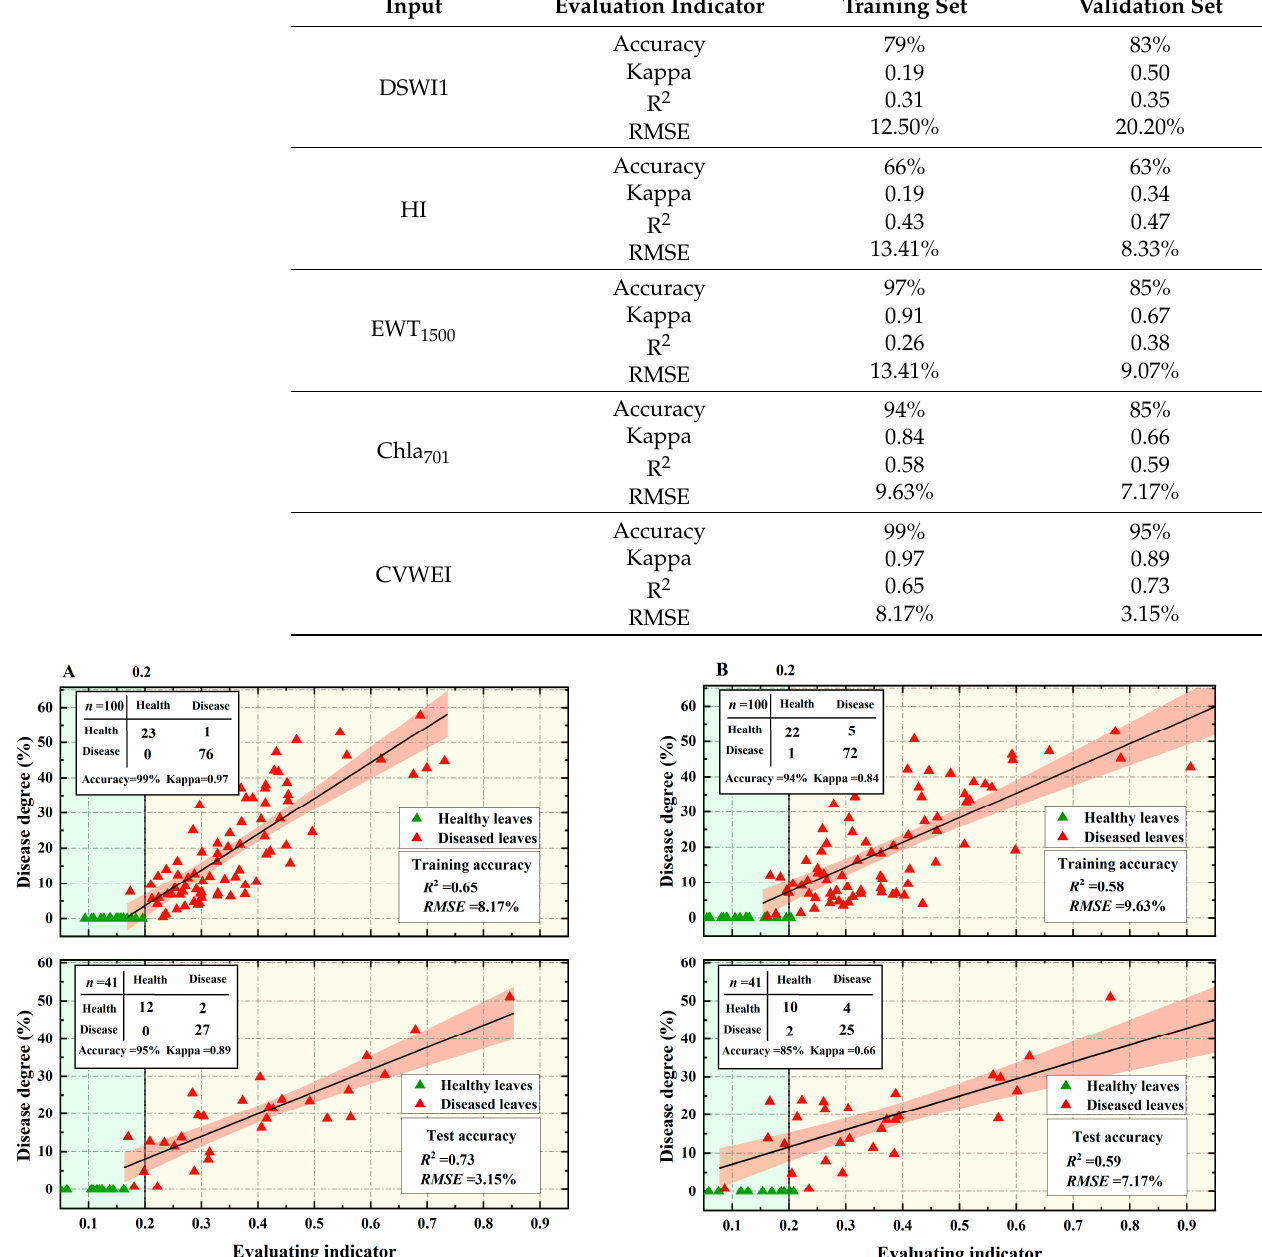
Figure 9. Accuracy evaluation of early detection indicators for VW. ( A ) CVWEI with multiple ‘symptom’ characteristics, ( B ) Chla 701 , the best constructed physiological spectral index correlating with severity under VW stress in cotton. The top panels are for the training set ( n = 100) and the lower panels are for the validation set ( n = 41). The red-shaded area represents the 95% confidence interval of fitting.